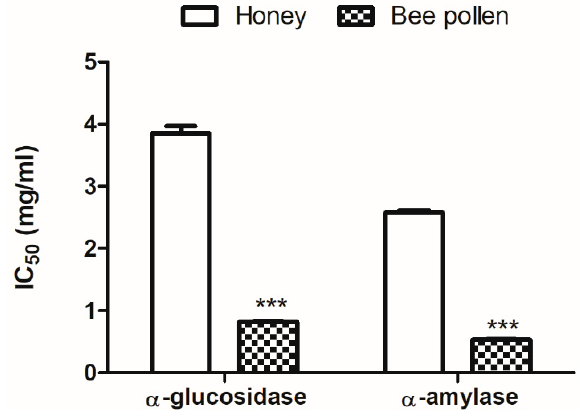
Figure 3. Inhibitory activity of α -glucosidase and α -amylase of honey and bee pollen. *** p < 0.001 vs. Honey samples.